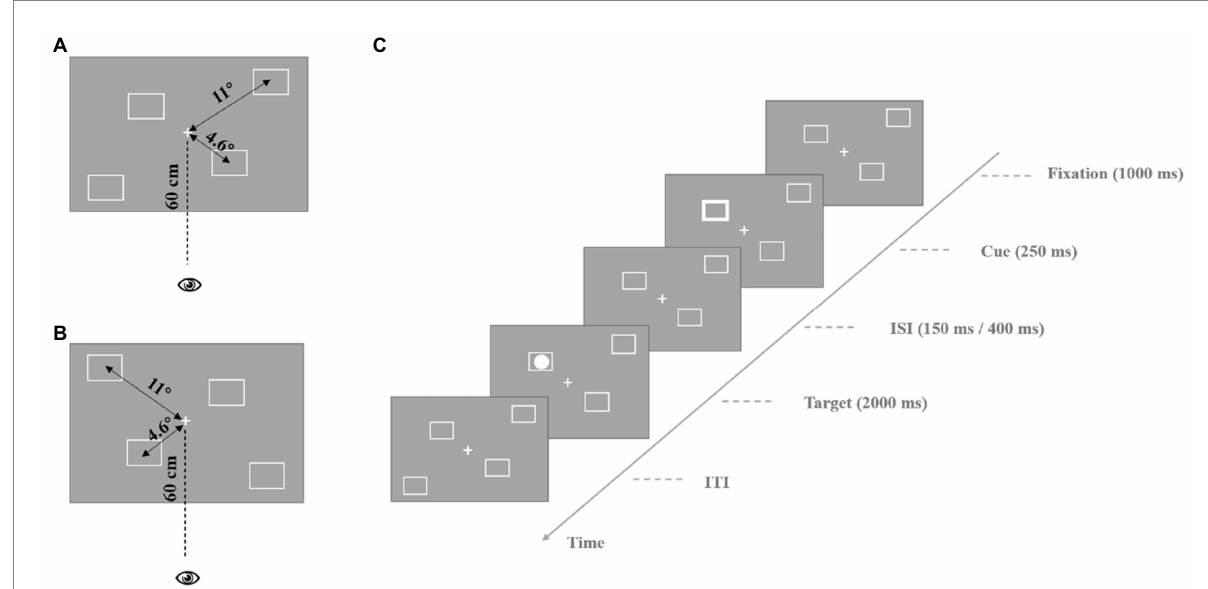
FIGURE 2 Process of exogenous cue experiment. (A) The stimulus parameters are presented in the experiment. The central location stimulus is presented at the participant’s 4.6 ° visual angle, the peripheral location stimulus is presented at the participant’s 11 ° visual angle, participant’s eyes are 60 cm away from the screen. (B) Different spatial distribution type of squares. The parameters of stimulus are the same as (A) . (C) The process of a single trail. ISI, inter-stimulus interval; ITI, inter-trial